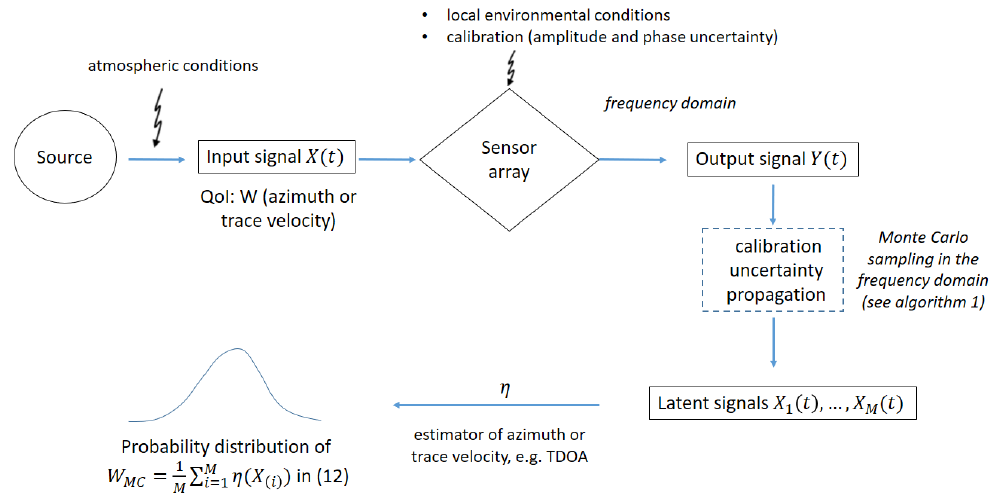
Figure 1. Flowchart of the methodology of uncertainty propagation in the frequency domain with the main uncertainty sources having an effect on the back azimuth and trace velocity of an infrasound wave. In this graph, W and W MC denote, respectively, a QoI and its Monte Carlo